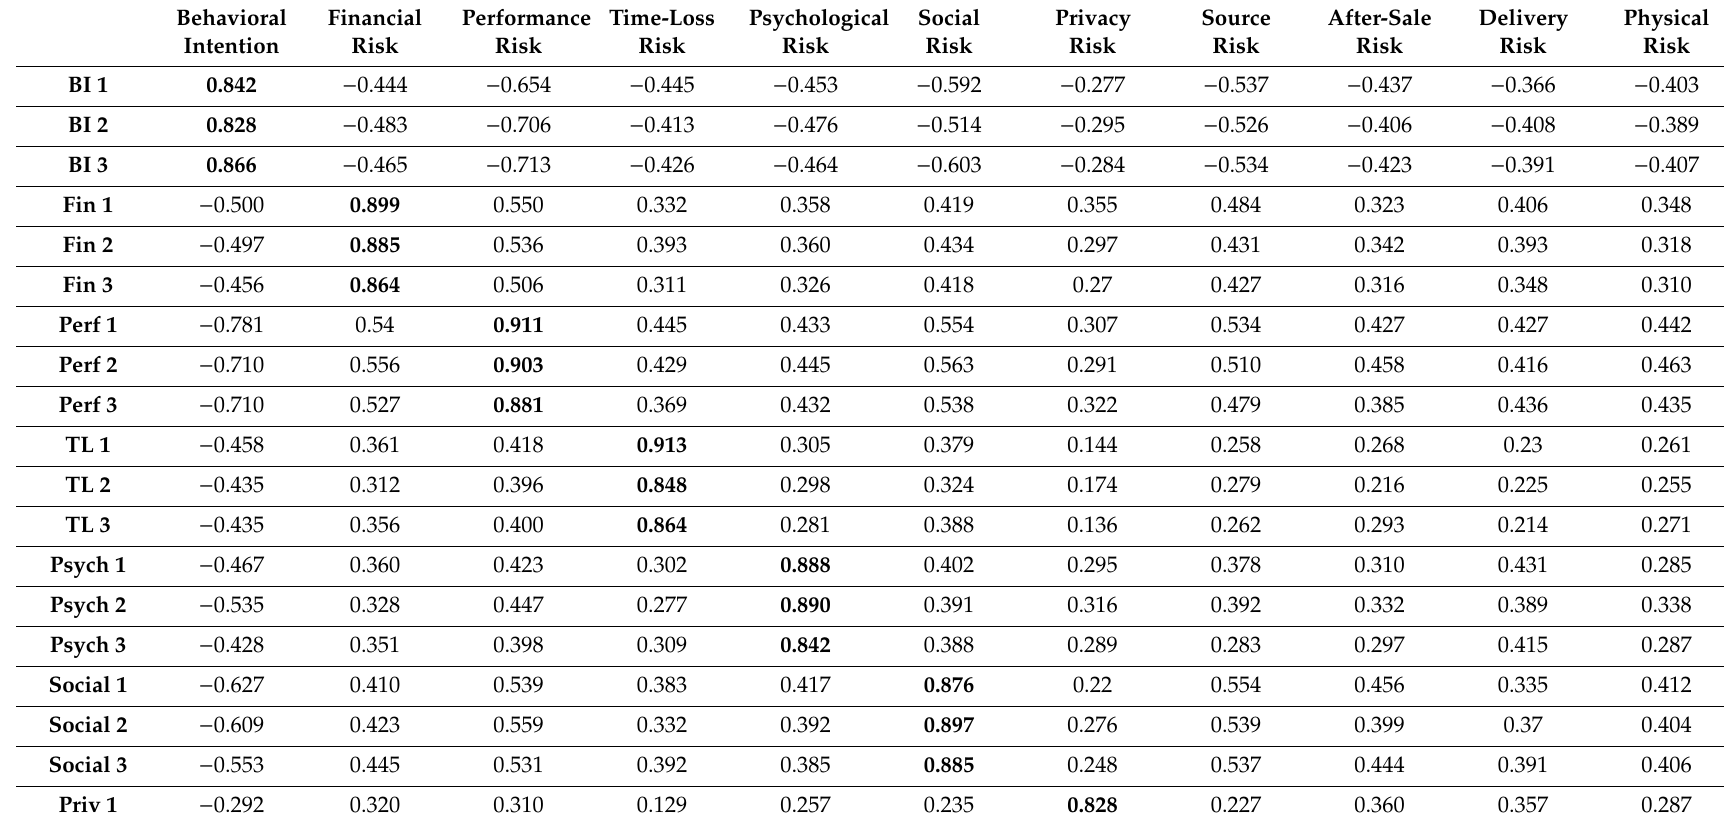
Table A2. Convergent validity